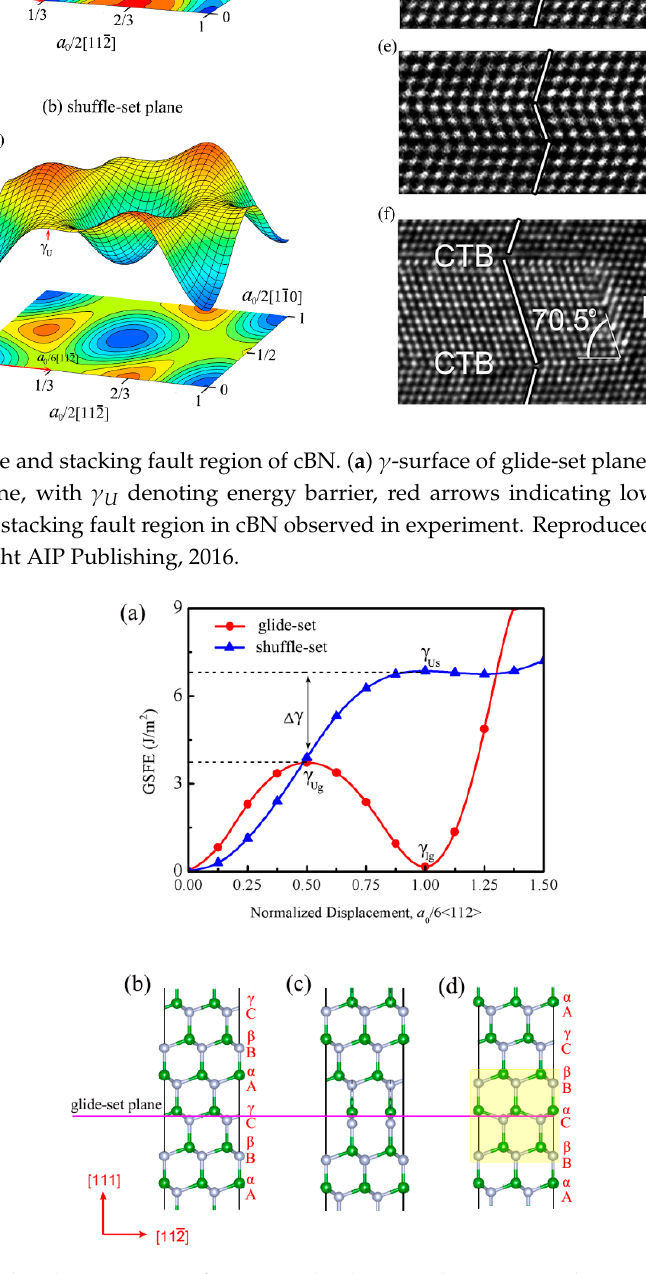
Figure 4. ( a ) Calculated GSFE curves for cBN in (111) < 112 > slip system, where γ Ug and γ Us denote energy barrier on glide-set and shu ffl e-set planes, respectively. Atomic configurations corresponding to three key structures in (111) < 112 > slip system: ( b ) initial configuration, ( c ) unstable configuration, and ( d ) metastable configuration, where light-yellow regions correspond to the stacking fault